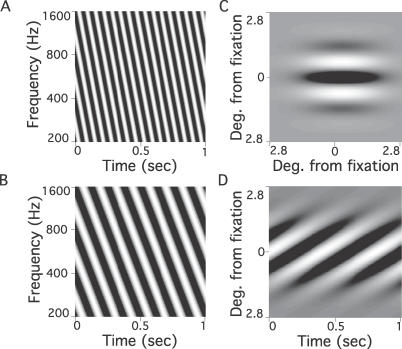
Auditory, Stationary Visual, and Moving Visual Stimuli(A and B) Spectro-temporal plots of two auditory moving ripple stimuli. The horizontal axis shows time in seconds; the vertical axis shows frequency content in Hertz (Hz). Brightness indicates the amplitude at a particular frequency and time; white represents sounds of greater amplitude. Modulations in frequency content are referred to as spectral density, defined by sinusoidal frequency Ω; modulations over time are referred to as the ripple's velocity, defined by sinusoidal frequency w. The ripple velocity for (A) is 16 Hz, and for (B), it is 8 Hz.(C) Image representing the static grating stimuli used. Horizontal and vertical axes represent actual spatial extent, in degrees visual angle from fixation, of visual stimuli.(D) Space–time plot of one moving grating stimulus. The horizontal axis shows time in seconds; the vertical axis shows the horizontal dimension in space (y). Brightness indicates the luminance at that point on the display. Moving visual gratings looked like (C) in which the bars drifted upwards over time.